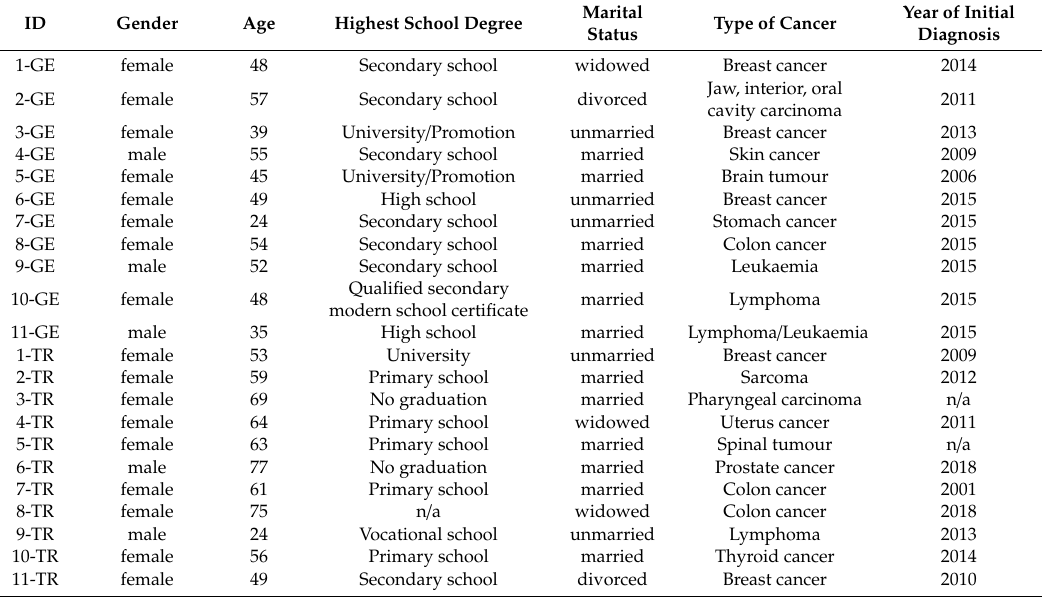
Table 1. Socio-demographic and clinical characteristics of German and Turkish cancer